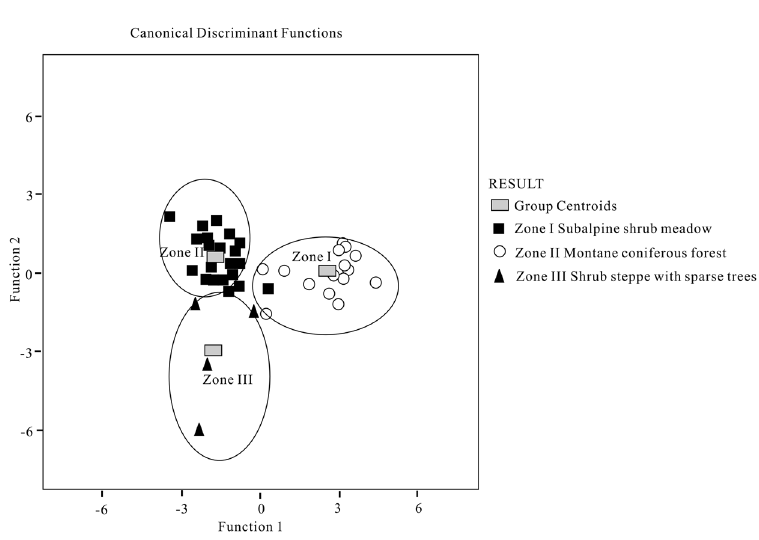
Figure 4. Ordination results of 42 surface pollen samples based on discriminant